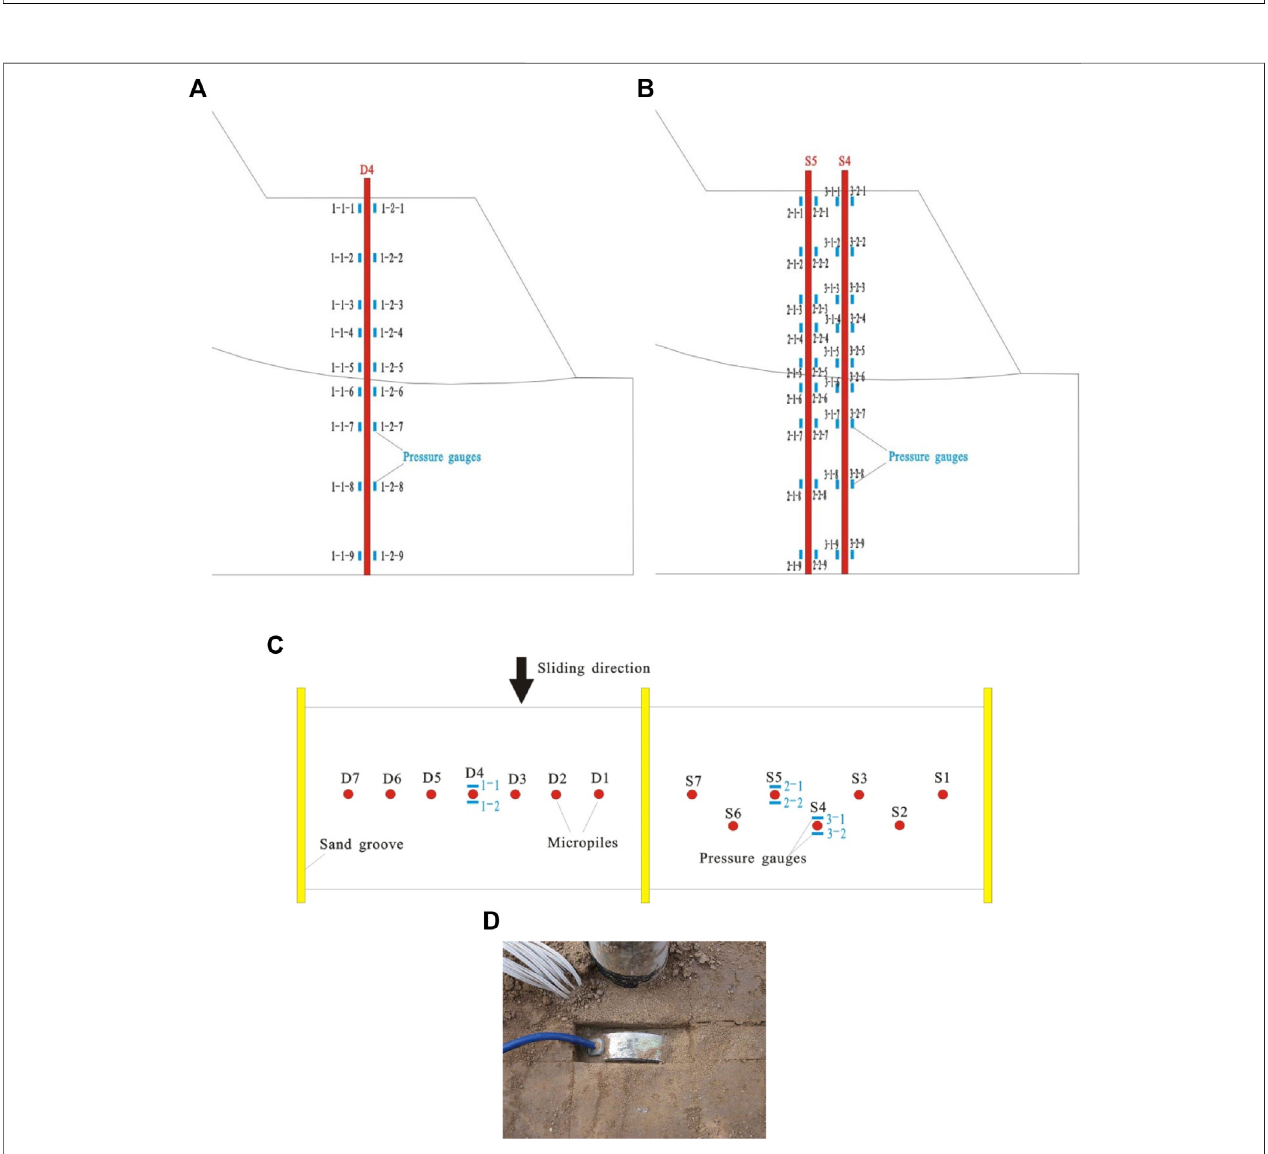
FIGURE 4 | Layout of the pressure gauges in the model: (A) distribution of the pressure gauges in the vertical direction along the pile in a single-row model, (B) distributionofthepressuregaugesintheverticaldirectionalongthepileinadouble-rowmodel, (C) distributionofthepressuregaugesinaplainview,and (D) embedded pressure